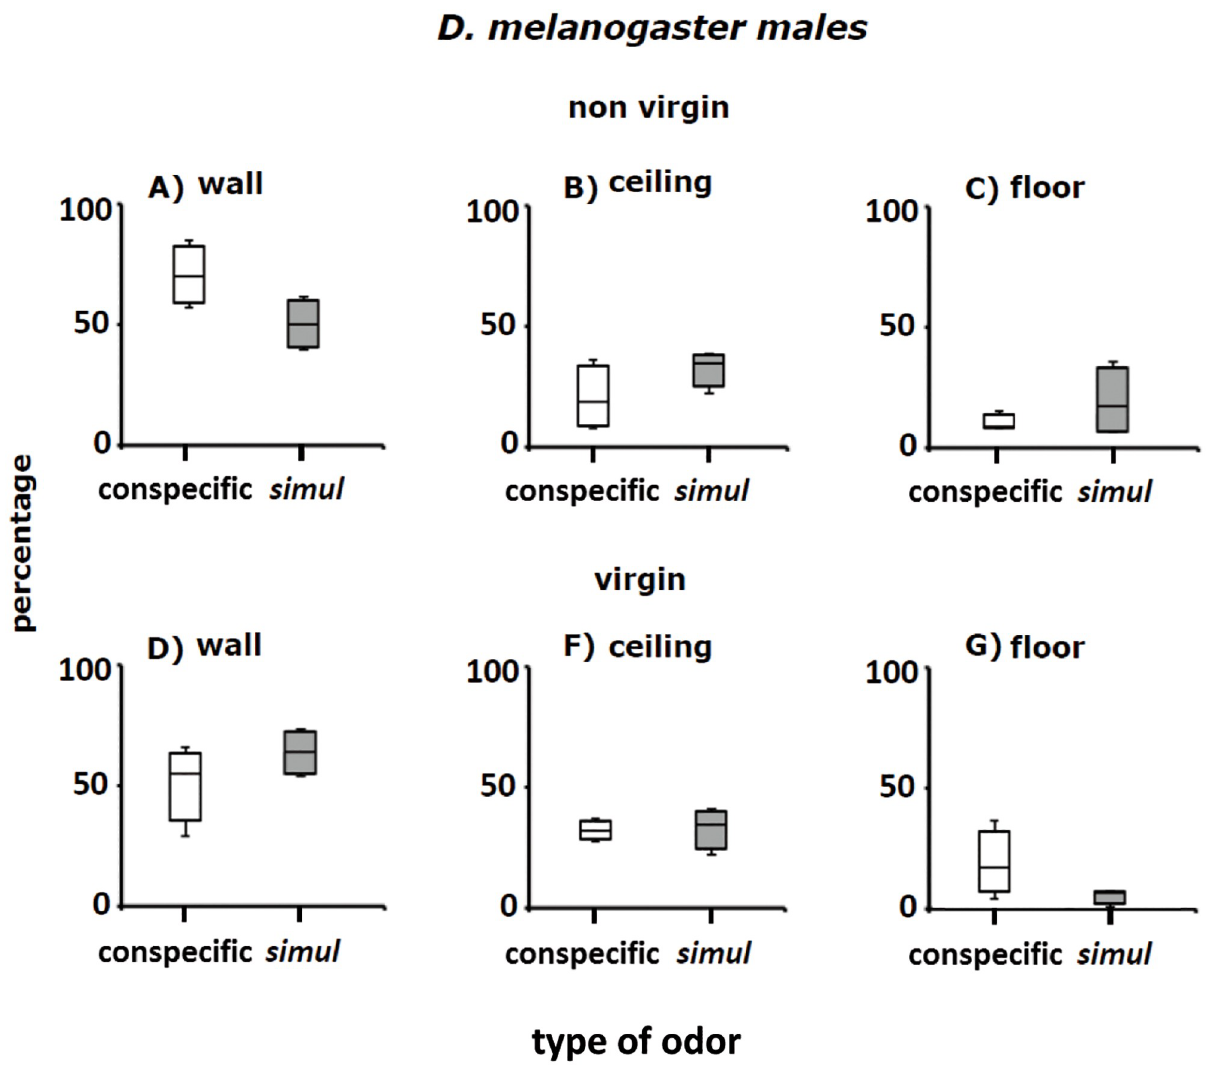
Fig 7. Perch preferences (percentages) of non-virgin and virgin males of D . melanogaster in Petri dishes. Perch preferences were examined in two types of Petri dishes: (i) impregnated with conspecific adult odorants (white columns), and (ii) saturated with adult odorants of D . simulans (grey columns). Fig 7 A–C and Fig 7 D–G show, respectively, percentages of non-virgin and virgin males of D . melanogaster perched on the wall, ceiling and floor of the Petri dishes. The horizontal black lines inside the boxes indicate median values. Bars outside the boxes show, respectively, maximum greatest values and minimum least values of the distributions. Conspecific is an abbreviation of Petri dishes with conspecific odors; simul stands for Petri dishes with odors of D . simulans .